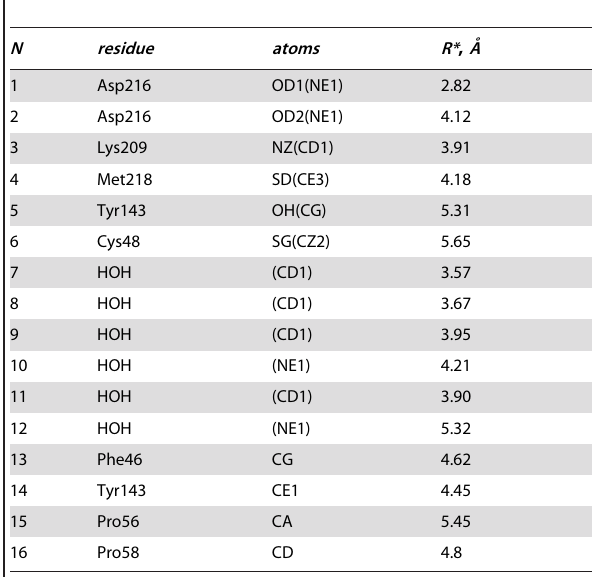
Table 3. Characteristics of the Trp57 microenvironment in